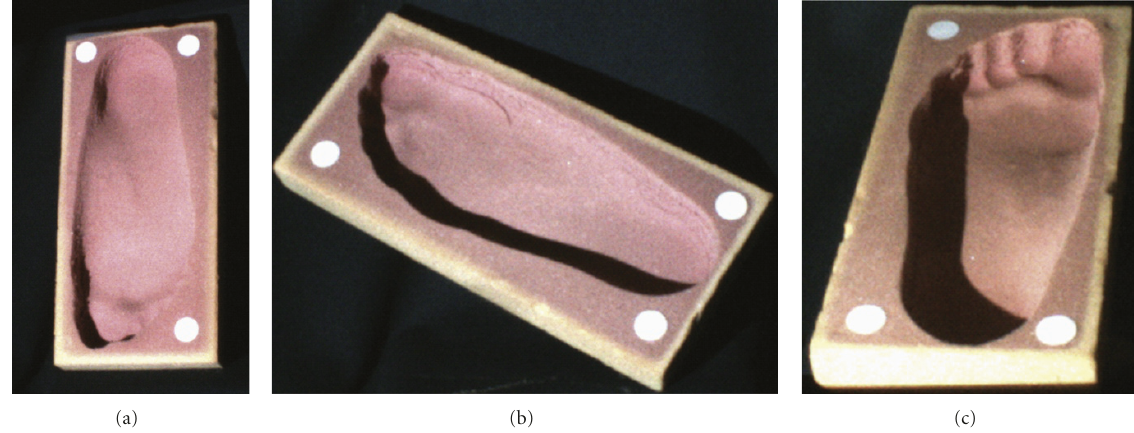
Figure 5: Images from three di ff erent views of the foot impression from our “foam box.”